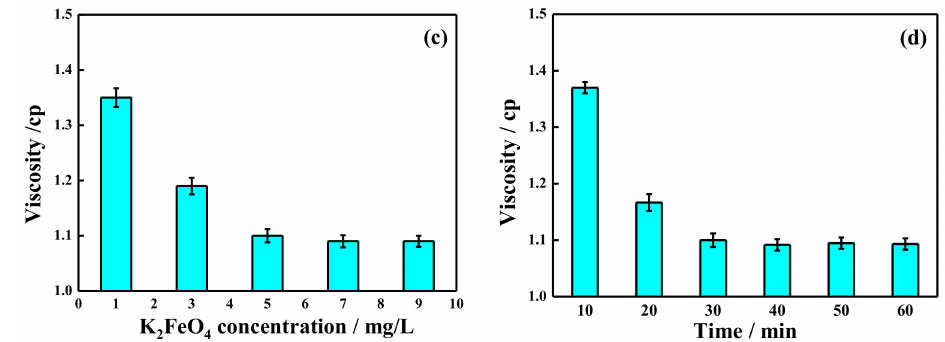
Figure 3. Visbreaking by potassium ferrate oxidation under di ff erent conditions of ( a ) pH value, ( b ) temperature, ( c ) the addition of potassium ferrate, and ( d ) reaction